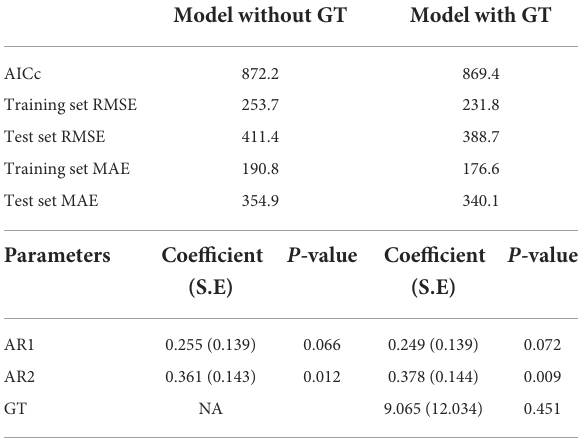
TABLE 2 Comparative performance assessment of the model without GT and the GT-enhanced model.